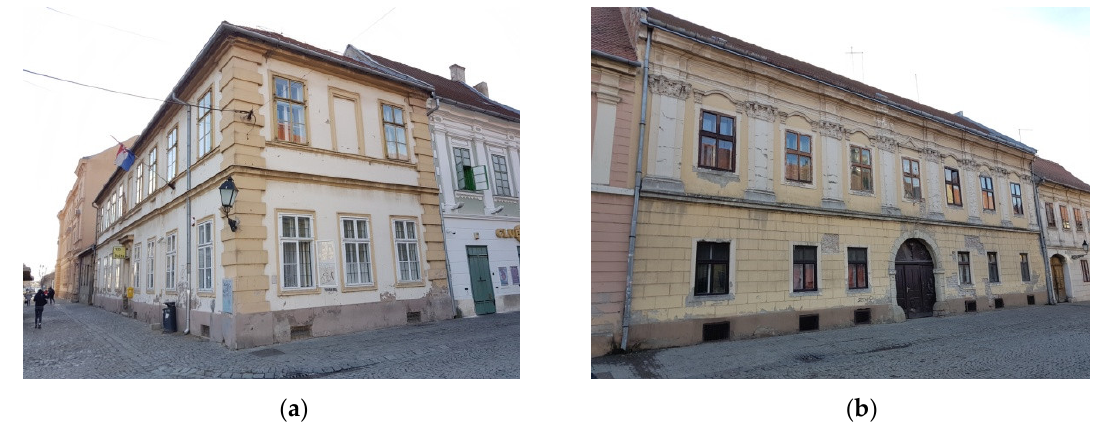
Figure 14. Kosti´c house ( a ) at the corner of Kuhaˇceva and Markovi´c street (2 Markovi´ceva Street) and Figure 14. Kostić house ( a ) at the corner of Kuhačeva and Marković street (2 Markovićeva Street) and ( b ) in 23 Kuhaˇceva Street. ( b ) in 23 Kuhačeva Street.